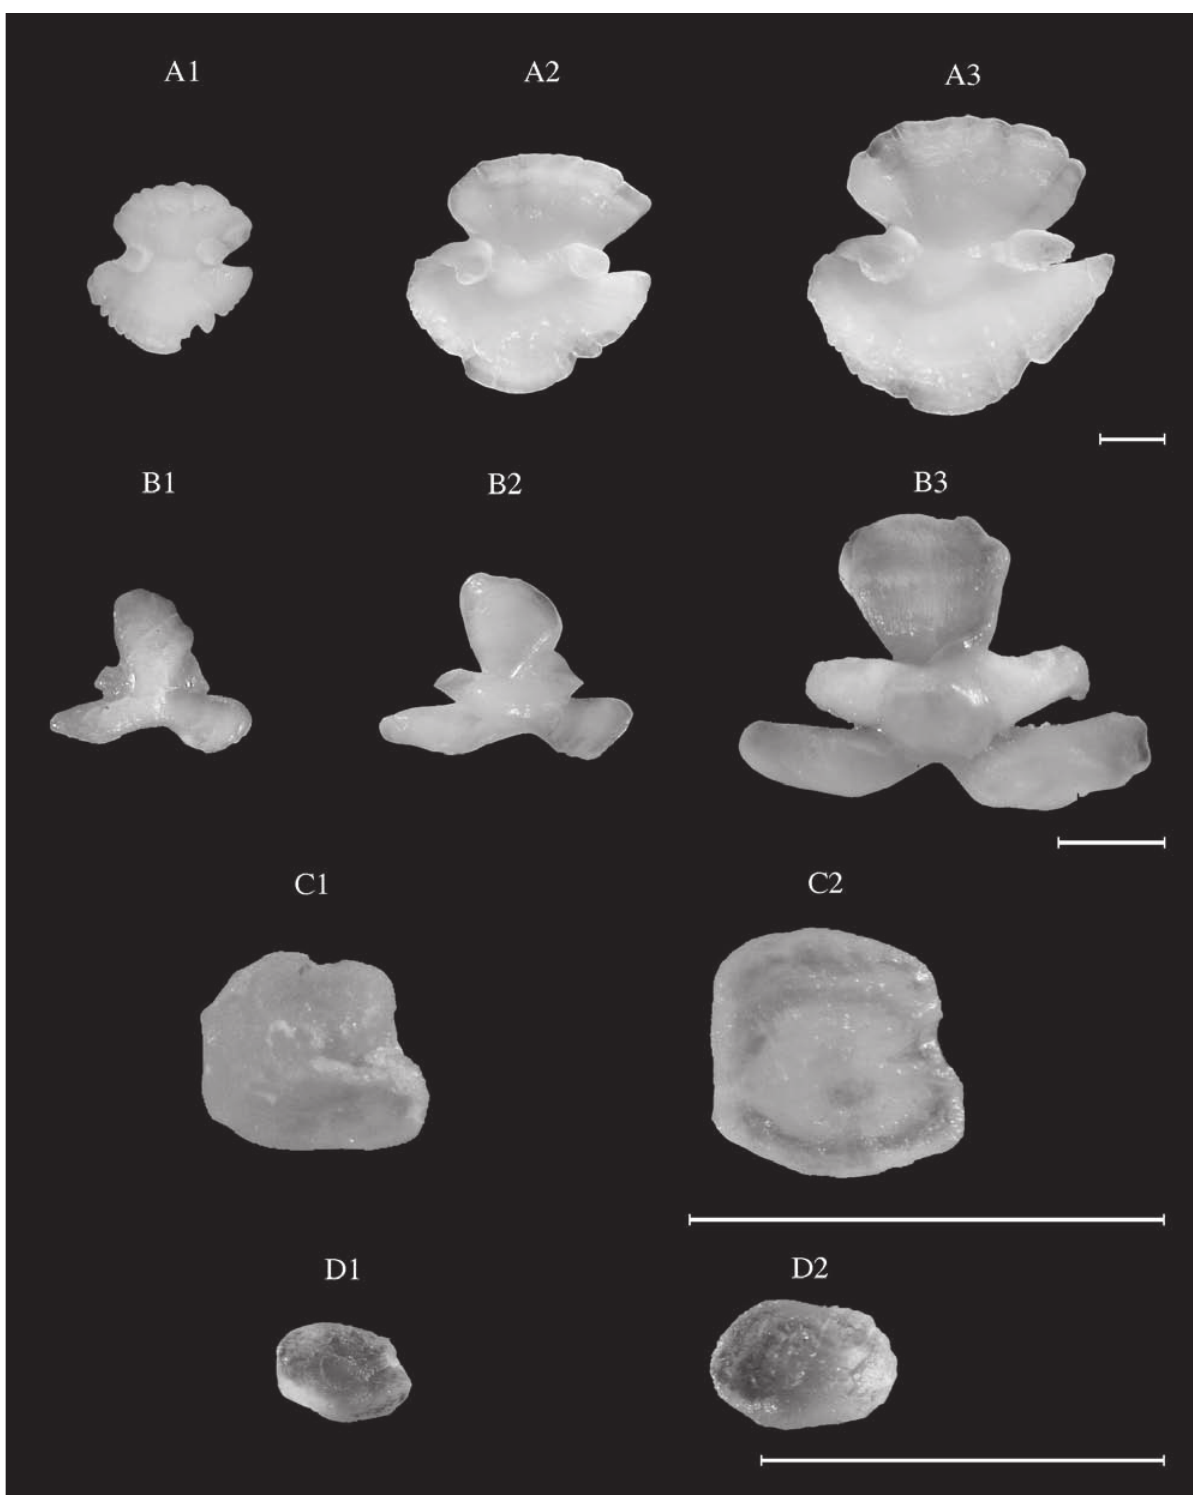
Fig. 39. – Cyttopsis rosea . TL: A1, 7.5 cm (CEA); A2, 17.5 cm (NEA); A3, 22.6 cm (NEA). Zeus faber . TL: B1, 15.0 cm (WM); B2, 32.1 cm (NEA); B3, 54.0 cm (CEA) Gasterosteus aculeatus (NEA). TL: C1 4.4 cm; C2, 5.8 cm. Hippocampus hippocampus (NEA). TL: D1, 10.5 cm; D2, 14.3 cm. Scale bar = 1